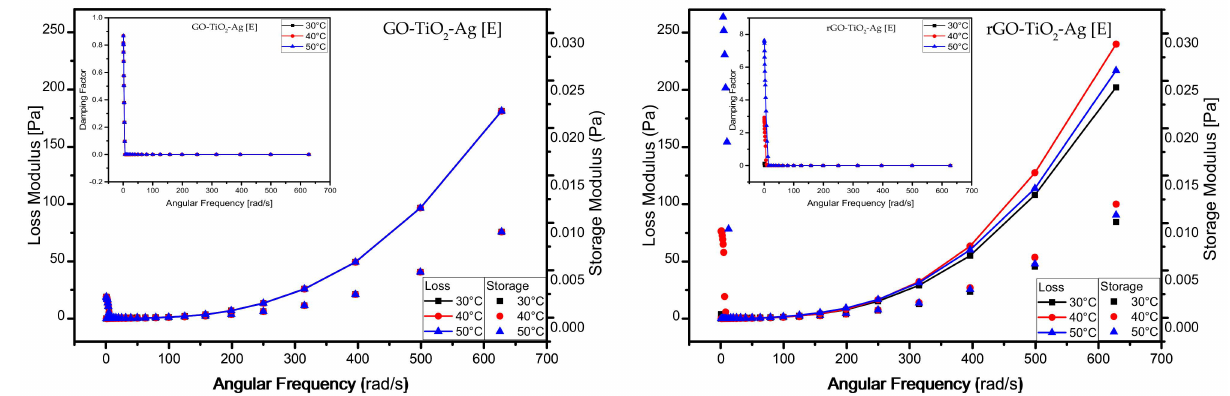
Figure 7. Frequency sweep—storage modulus and loss modulus vs. shear stress and their damping factor (inset) at different temperatures of ternary hybrid nanoparticles. ( A – E ) are serial